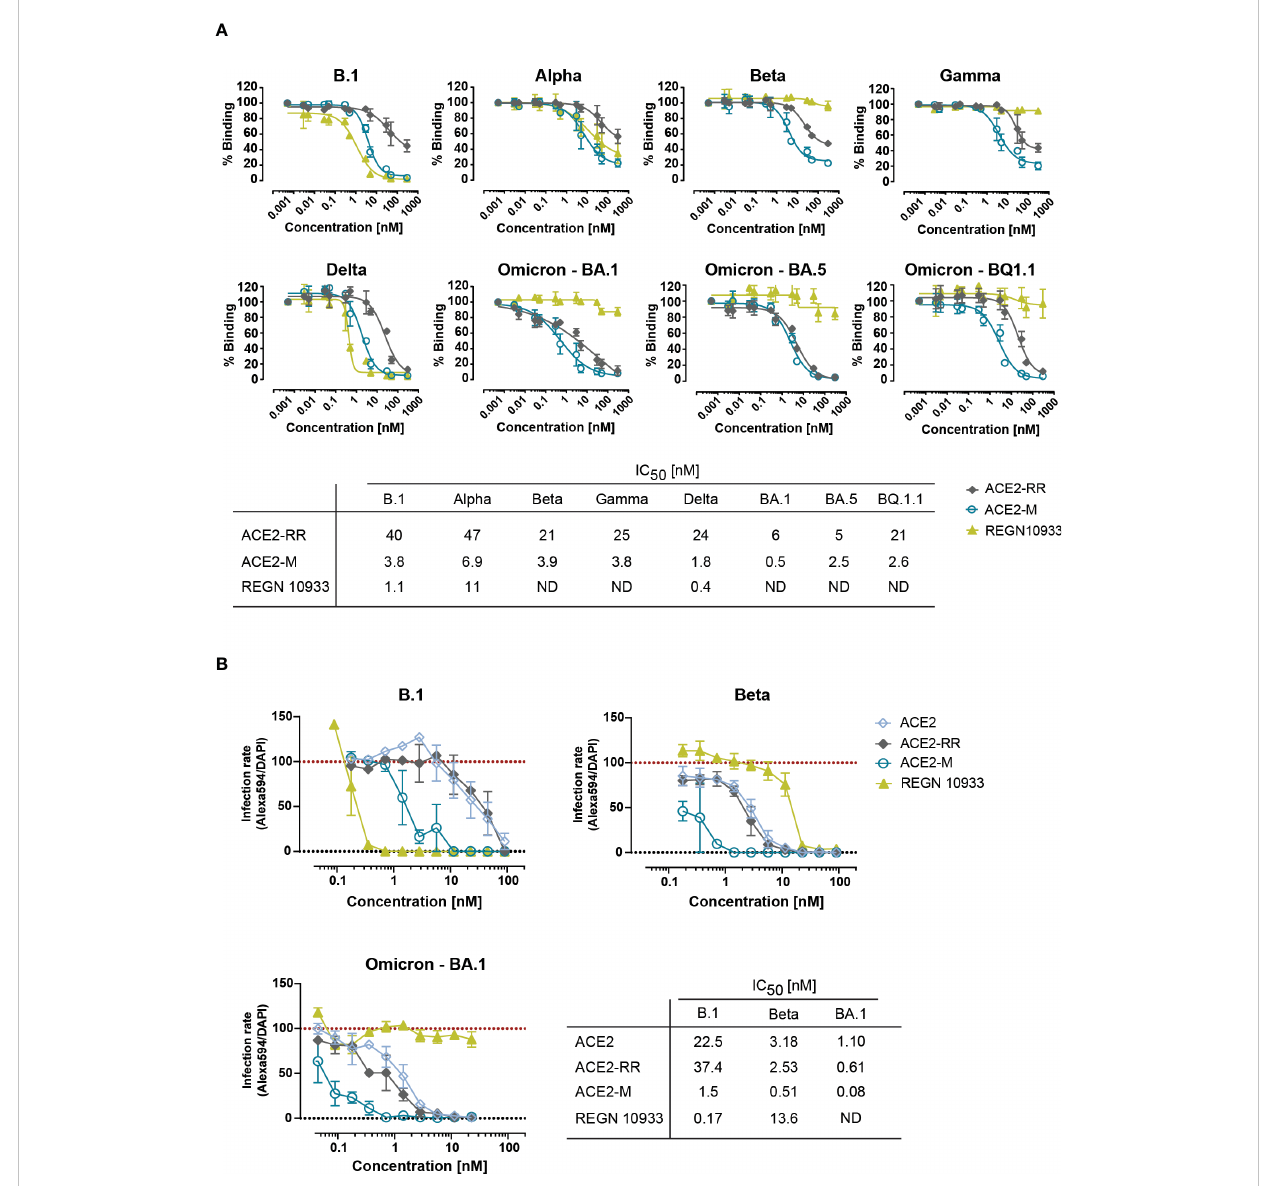
FIGURE 2 Competitive binding of fusion proteins and REGN 10933 to ACE2 and their capacity to neutralize parental and SARS-CoV-2 VOCs. (A) Competitive ELISA was performed by immobilizing the indicated full length S-proteins. The results depicted show the binding of 150 nM of His-tagged ACE2 wild-type protein, that was competed with the indicated concentrations of the ACE2 fusion molecules or REGN 10933 antibody. The error bars represent the SD of two independent experiments with technical replicates. The IC 50 values summarized in the table were calculated using the GraphPad software. ND: Not detected. (B) Neutralization capacity was determined as described in material and methods. Brie fl y, Caco-2 cells were infected with the indicated clinical isolates of SARS-CoV-2. Infection rates, calculated as the number of infected cells (Alexa594+) over the total number of cells (DAPI+), were normalized to virus-only infection control. Mean and SEM values are calculated from three independent experiments with technical duplicates. Neutralization assay corresponding IC 50 values were calculated using GraphPad software. ND, Not